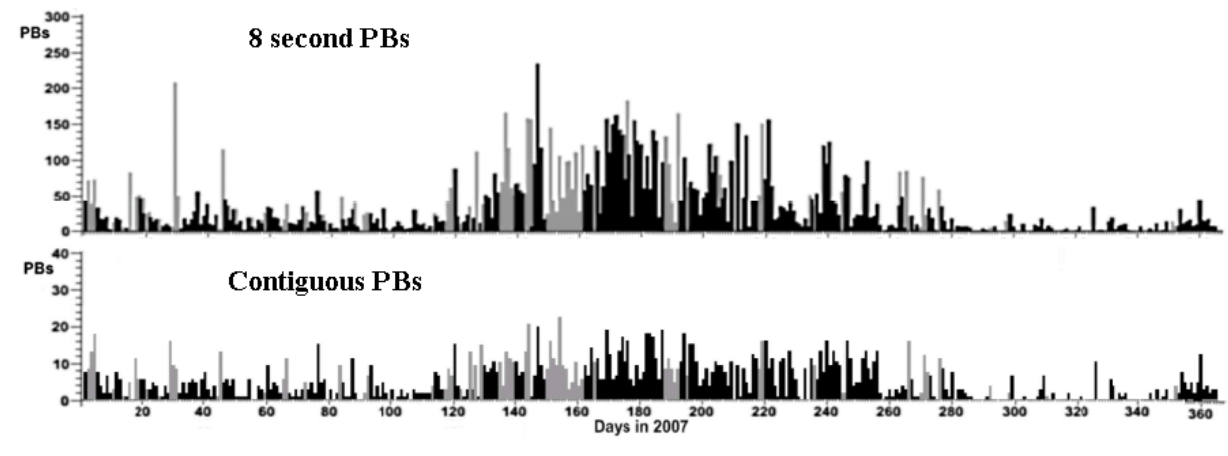
Figure 4. The daily distribution of elementary (8 second) and contiguous PBs during solar quiet (black) and solar perturbed (gray) periods in 2007 of the NOAA-15 electron detector at 0°, in the energy range 30–100